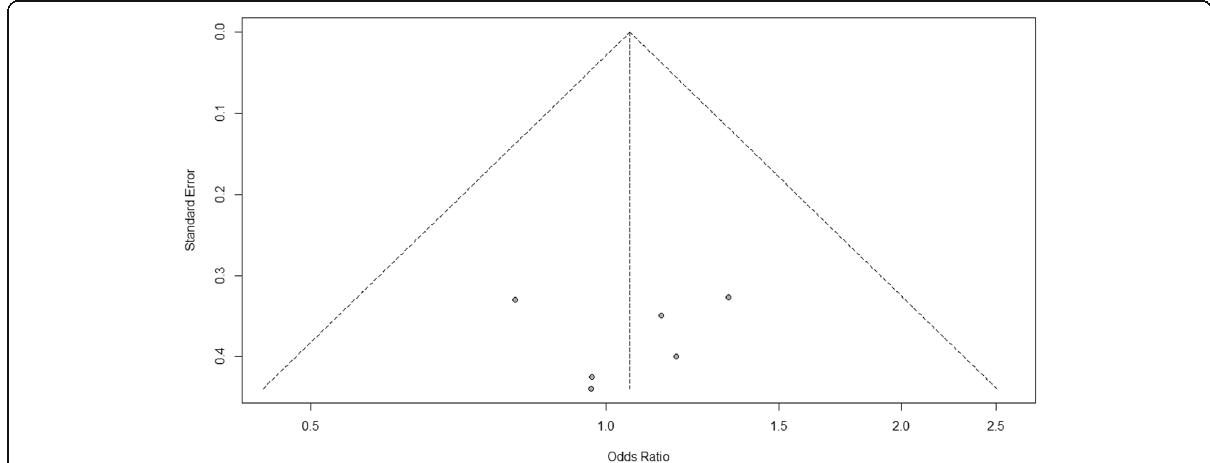
Fig. 4 Publication bias funnel plot for comparison of vaccine A versus